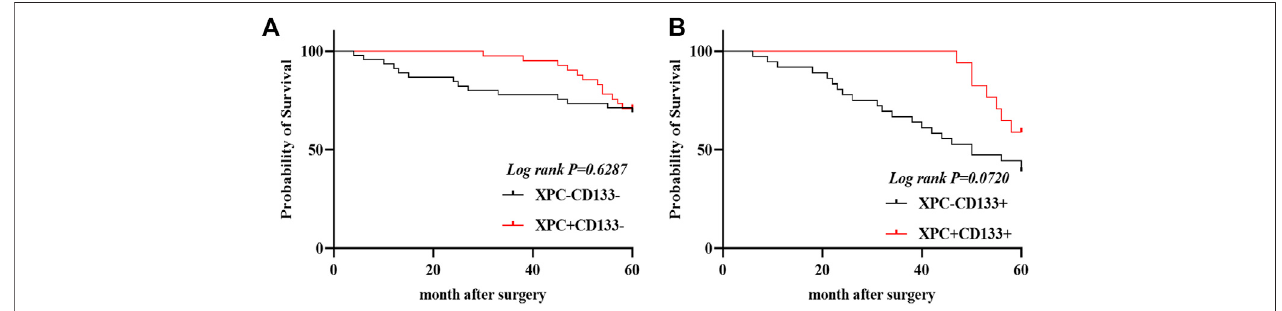
FIGURE4| XPCandCD133co-expressionKaplanMeiercurve. (A) .140patientsweredividedintofourgroups:CD133andXPCarebothhighexpression:CD133+XPC+, CD133 high expression and XPC low expression: CD133+XPC − , CD133 low expression and XPC high expression: CD133 − XPC+, CD133 and XPC has low expression: CD133 − XPC − . Compared with the CD133+XPC − group, the CD133+XPC+ group is associated with a better prognosis of lung adenocarcinoma ( Log-rank p (cid:1) 0.6287). (B) . Compared with the CD133 − XPC − group, the CD133-XPC + group is associated with a better prognosis of lung adenocarcinoma ( Log-rank p (cid:1) 0.0720).